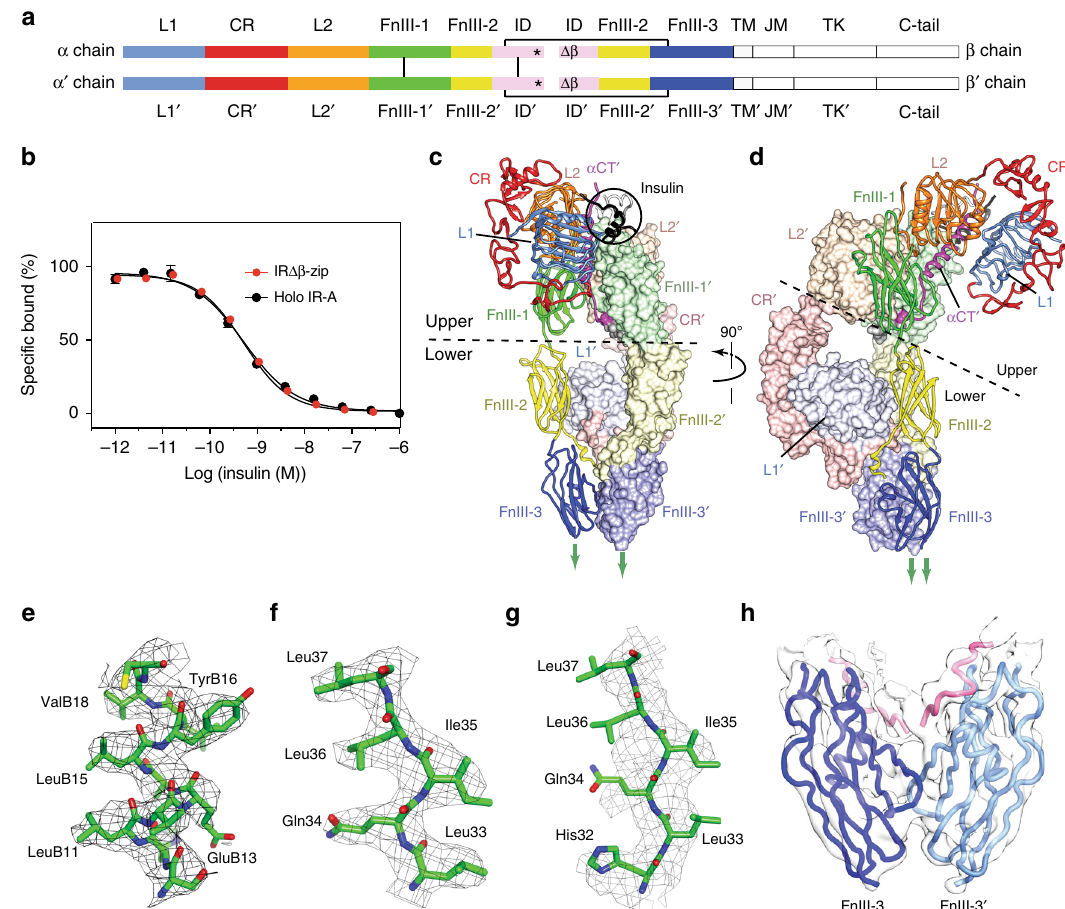
Fig. 1 Insulin receptor structural biology. a Receptor domain layout 5 . L1 and L2: fi rst and second leucine-rich repeat domains, CR: cysteine-rich domain, FnIII-1, -2 and -3: fi rst-, second and third fi bronectin Type-III domains, ID: insert domain, asterisk: α -chain C-terminal region ( α CT), TM, JM: trans- and juxta-membrane domains, TK: tyrosine kinase domain, C-tail: β chain C-terminal segment. Black lines: inter-chain disul fi de bonds; Δβ ː location of the glycosylated segment mutated/deleted in IR Δβ 5 . Domains within the second αβ polypeptide are distinguished by a prime ( ′ ) symbol. b Competition- binding curve for insulin binding to IR Δβ -zip immuno-captured from conditioned cell-culture medium (IC 50 = 0.55 ± 0.02 nM; n = 4 technical replicates) compared to that for hIR-A immuno-captured from solubilized cell membranes (IC 50 = 0.46 ± 0.06 nM; n = 4 technical replicates). Error bars (s.e.m.) are smaller than marker size when absent. The logIC 50 values are identical at the 95% degree of con fi dence based on an F test ( P = 0.171; no. of degrees of freedom = 80). c , d Orthogonal views of cryoEM structure of IR Δβ -zipInsFv. Circle: location of insulin. Fv modules are not shown but are attached to the respective CR domains as in prior X-ray crystal structures 5,38 (see Supplementary Figure 4). e – h Sharpened density derived from the focused maps, covering (respectively) segments of the insulin B chain, domain L1 (insulin-bound), domain L1 ′ (insulin-free), and the dimeric FnIII-3:FnIII-3 ′